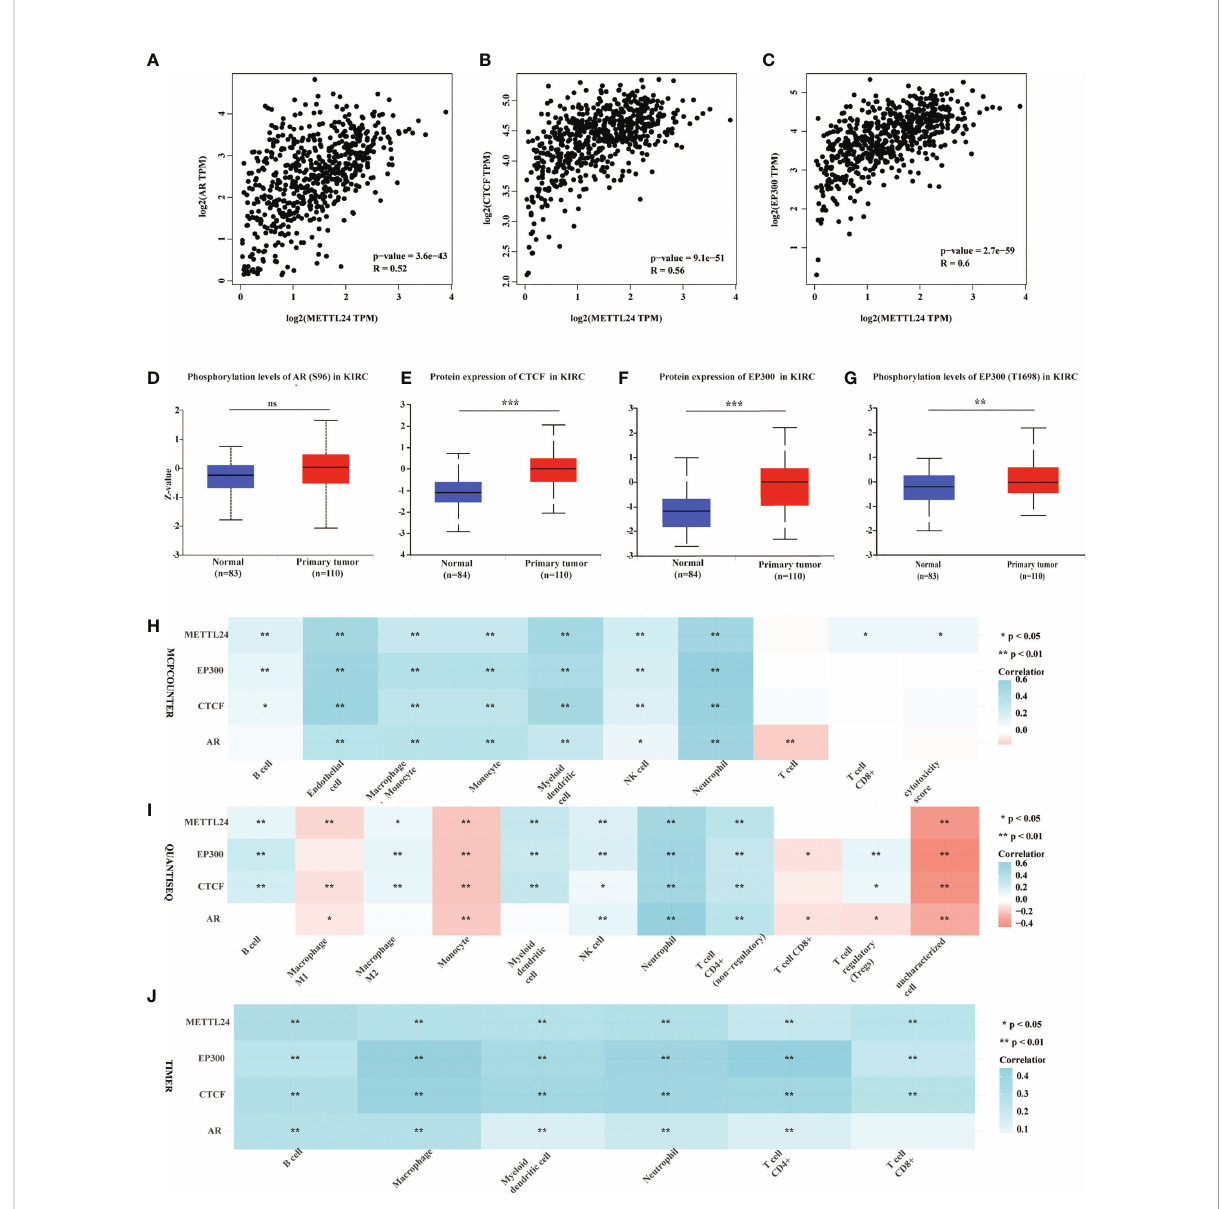
FIGURE 8 Protein levels and phosphorylation content of EP300, CTCF and AR, the possible METTL24 transcription factors, were altered in KIRC tissues compared to normal kidney tissues. The Spearman correlation between METTL24 expression and (A) AR, (B) CTCF, and (C) EP300 expression in KIRC. The phosphorylation levels of (D) AR and (E) EP300 in KIRC and normal kidney tissues. The protein expression levels of (F) CTCF and (G) EP300 in KIRC versus normal kidney tissues. The correlation between METTL24, EP300, CTCF, AR expression and the in fi ltration degrees of distinct immune cells in KIRC as analyzed using (H) MCPCOUNTER, (I) QUANTISEQ, and (J) TIMER algorithms. ***p < 0.001,**p < 0.01 and *p < 0.05; ns, not signi fi